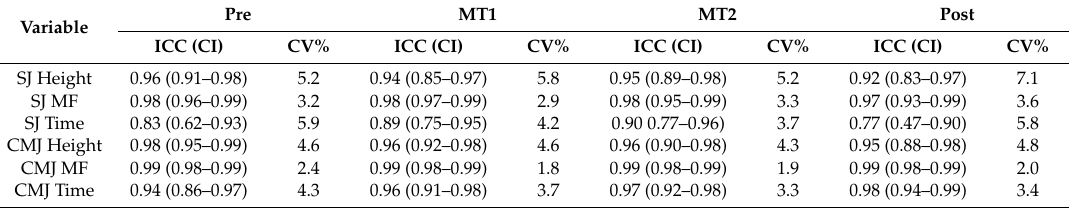
Table 4. Reliability statistics for squat jump (SJ) and countermovement jump (CMJ)